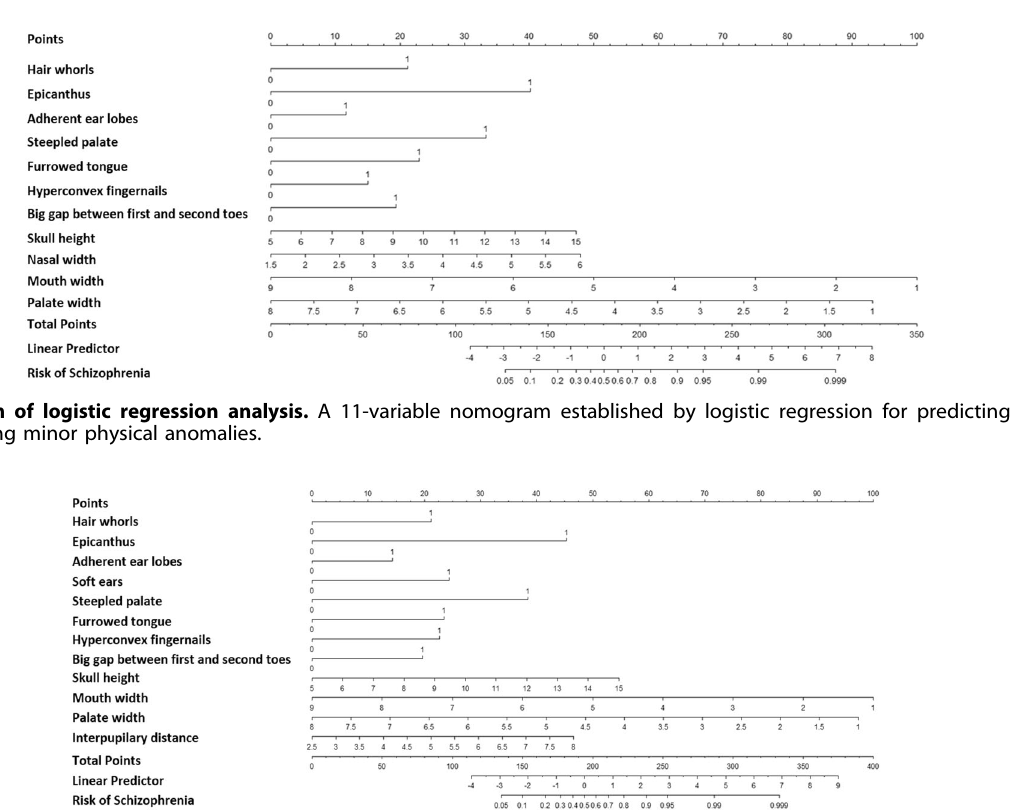
Fig. 2 Nomogram of Lasso regression analysis. A 12-variable clinical nomogram established by Lasso regression for predicting the risk of schizophrenia using minor physical